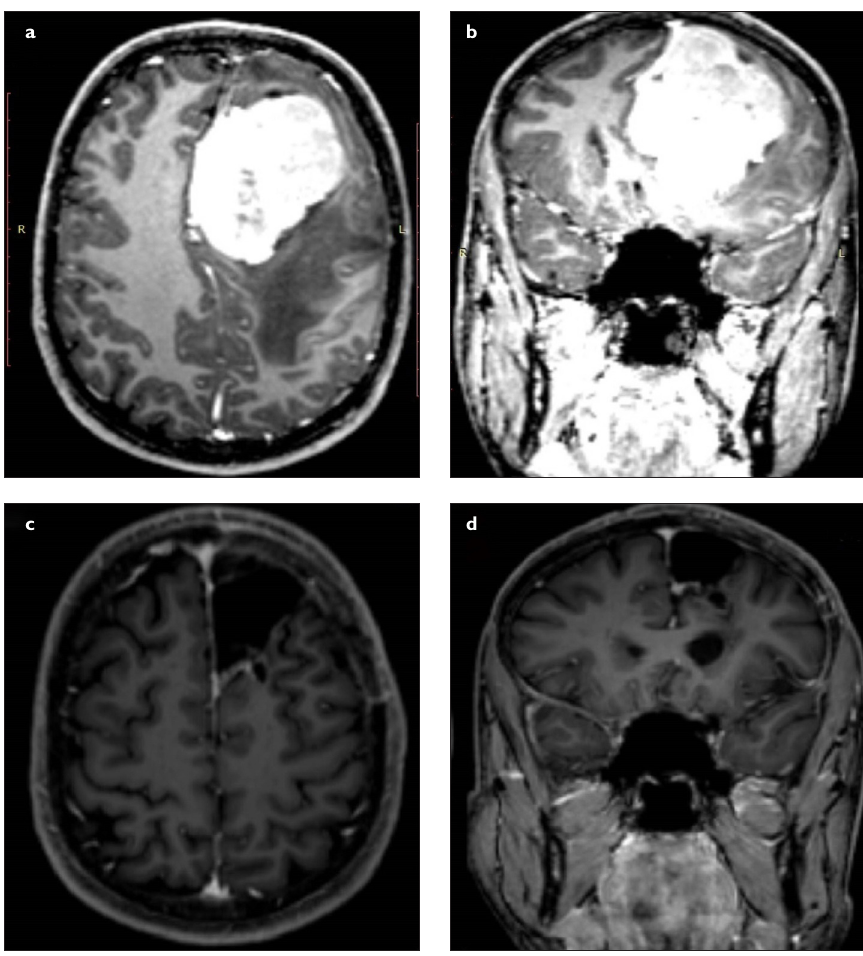
Figure 1. a-d. (a) Preoperative axial and (b) coronal MRI scans of a patient with giant left frontal meningioma originating from the falx cerebri. The patient underwent surgical resection using left frontal craniotomy. (c) Postoperative axial and (d) coronal MRI scans confirmed gross total resection. MRI, magnetic resonance